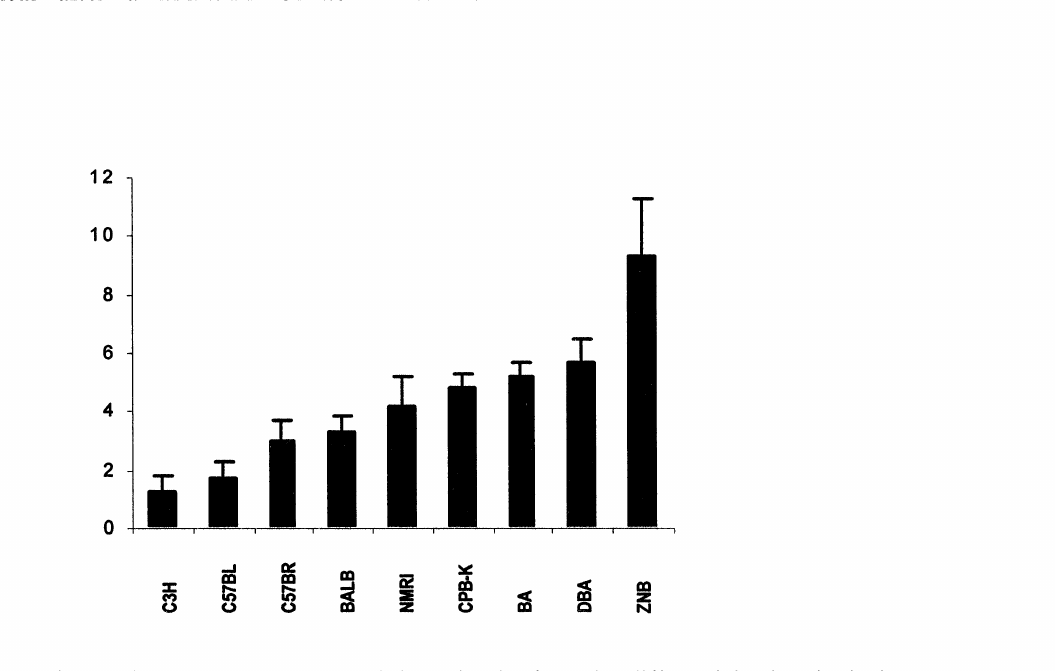
Fig. 1: Mean numbers of errors (repeat arm entrances) made by male mice from nine different inbred strains in the eight-arm radial maze on the fifth trial, one trial/day, six males per strain (data from Schwegler et al.,